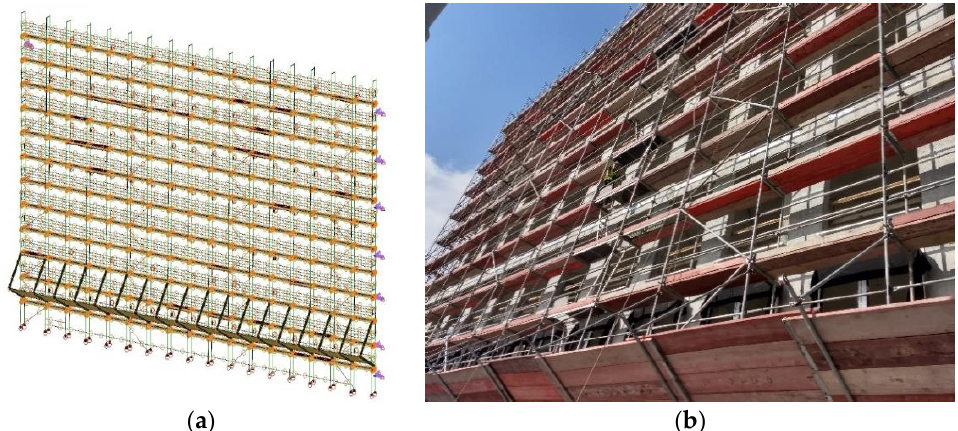
Figure 2. Scheme ( a ) and view ( b ) of the analyzed scaffolding.